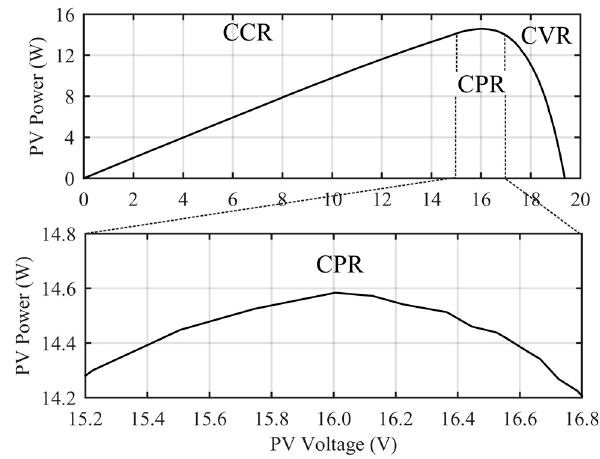
Figure 5. Authentic P-V curve of Raloss SR30-36 PV panel ( top ); and the extended view of the CPR ( bottom ) (Note: MPP equals 16 V).